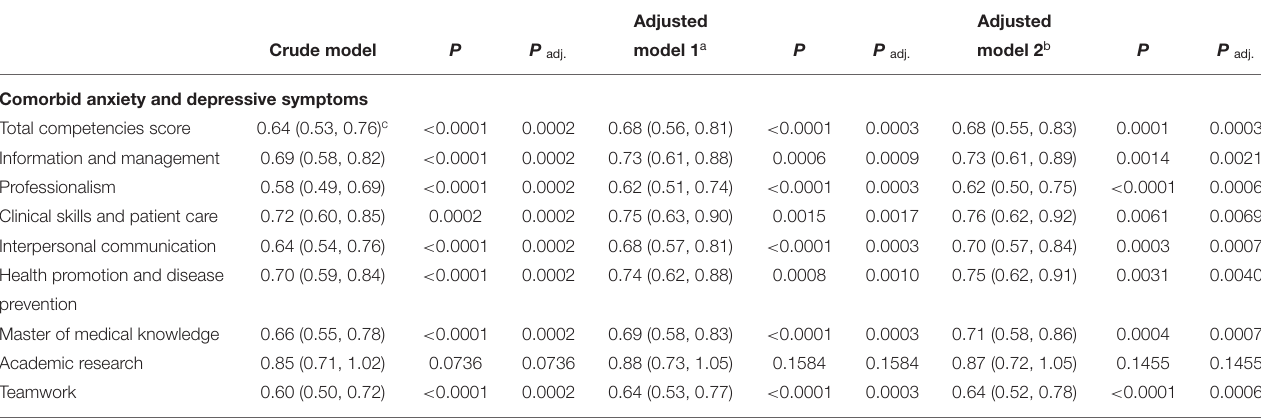
TABLE 4 | Associations between competencies, and comorbid anxiety and depressive symptoms among frontline medical staff during the COVID-19 outbreak.